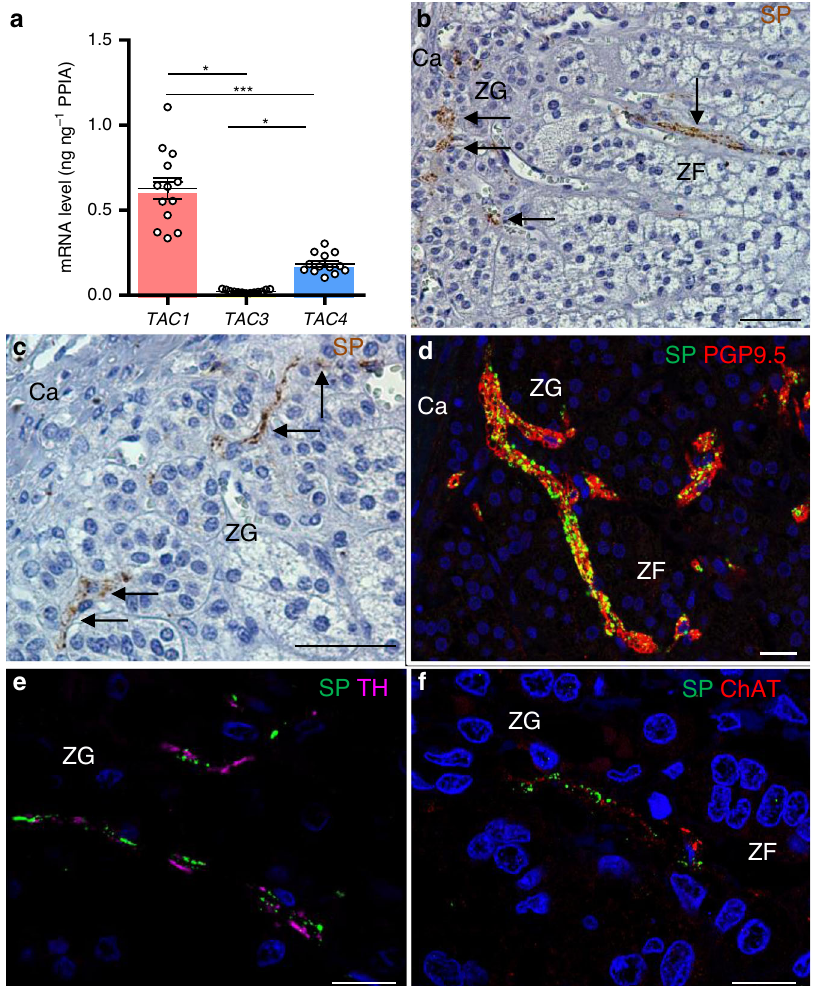
Fig. 1 Expression of substance P (SP) in the human adrenal gland. a Quantitative RT-QPCR analysis of TAC1 , TAC3 and TAC4 mRNAs ( n = 13 independent adrenals). Each dot indicates one adrenal. Data are presented as mean ± SEM. CI 95%: 0.49 – 0.76, 0.017 – 0.028, 0.15 – 0.22 for TAC1 , TAC3 and TAC4 , respectively. Statistical analysis was performed by Kruskal – Wallis test and Dunn ’ s post-test after one-way ANOVA. Signi fi cance denoted by *** p < 0.001, * p < 0.05. b , c Distribution of SP immunoreactivity in the adrenal cortex. Arrows designate nerve fi bres. (Ca capsule, ZG zona glomerulosa, ZF zona fasciculata; scale bars = 50 µ m; microphotographs representative of n = 18 independent adrenals). d – f Double immuno fl uorescence detection of SP and the nerve fi bre marker PGP9.5 ( d ), tyrosine hydroxylase (TH; e ), a marker of adrenergic nerve fi bres, or choline acetyltransferase (ChAT; f ), a marker of cholinergic nerve fi bres. (scale bars = 20 µ m; microphotographs representative of n = 4, 14 and 4 independent adrenals in d – f ,